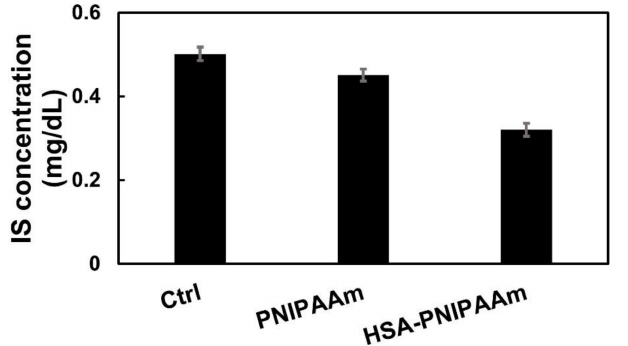
Figure 6. ( a ) The process of BSA-PNIPAAm conjugates thermal precipitate. ( b ) Effects of monomer ratio to CTA on BSA recovery ratio (PN: Free PNIPAAm). ( c ) Effects of CTA ratio to BSA-on BSA recovery ratio (PN: Free PNIPAAm). Calculated from precipitation (black) and a balance between original solution and supernatant (gray). (mean ± SD, n = 3).